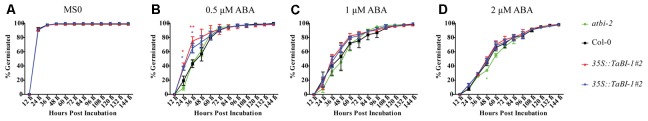
TaBI-1.1 transgenic Arabidopsis exhibit decreased sensitivity to ABA during germination. Germination of atbi1-2, Col-0, and 35S::TaBI-1.1 transgenic Arabidopsis on MS0 medium (A) or medium containing 0.5 μM ABA (B), 1 μM ABA (C), or 2 μM ABA (D). The vertical coordinates represent the percentages of germinated seeds, and the horizontal coordinates represent hours post-incubation. The number of germinated seeds was recorded every 12 h post-incubation. Error bars indicate the SDs. The data represent the means ± SDs of three independent biological replicates. Asterisks indicate significant differences (∗P < 0.05 and ∗∗P < 0.01) compared with Col-0 (Student’s t-test).